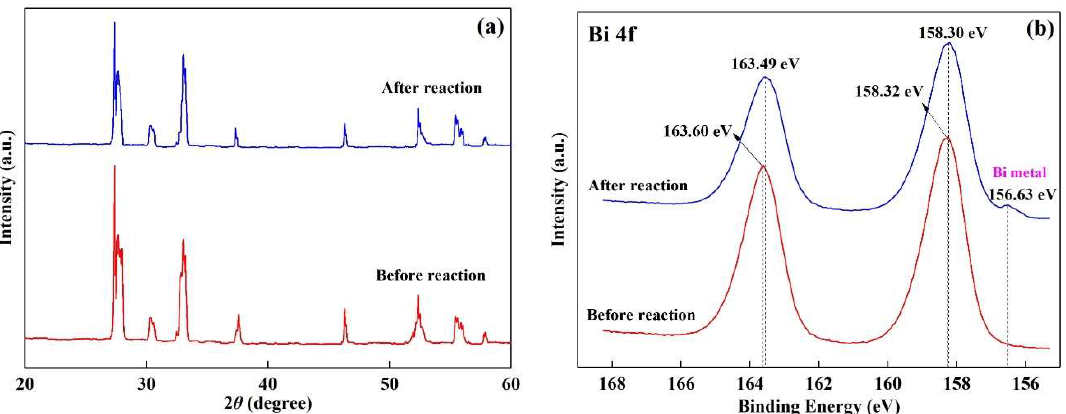
Figure 8. ( a ) XRD pattern; ( b ) Bi 4f X-ray photoelectron spectrum (XPS) of the composite catalyst CuBi 2 O 4 / β -Bi 2 O 3 (1:2.25, 600 ◦ C) before and after reaction for seventh times.